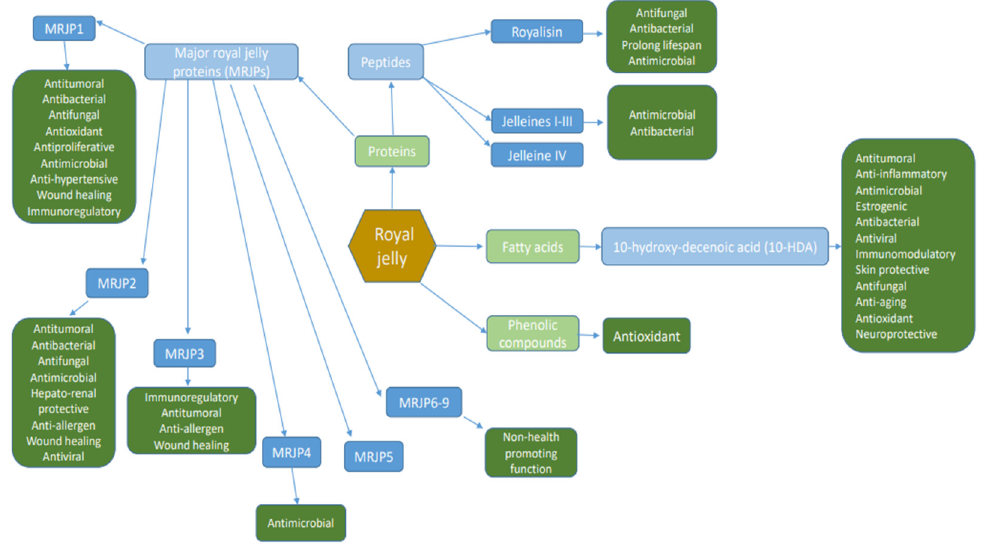
Figure 1. A schematic representation of RJ’s bioactive compounds and their functional